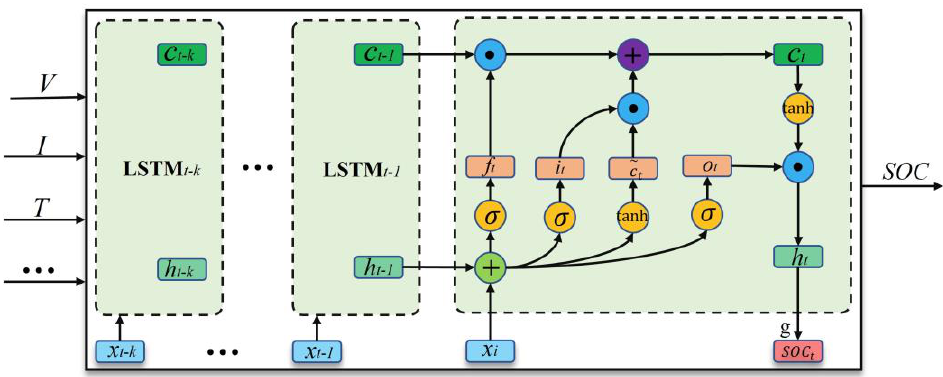
Figure 2. Schematic diagram of the LSTM predictor.